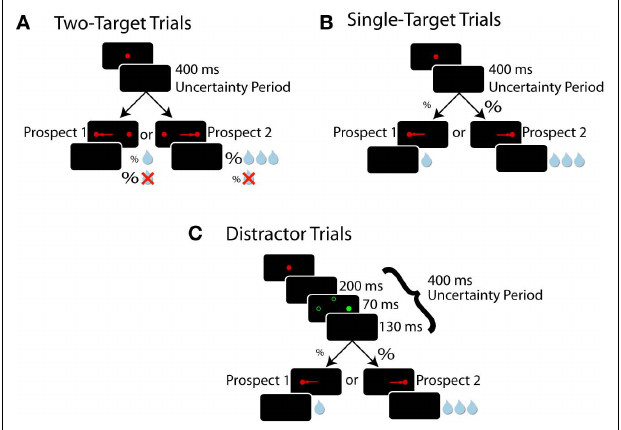
FIGURE 1 | Experimental paradigms. Each window represents what the monkey sees chronologically ordered from top to bottom. Red filled circles represent targets, green filled circles represent distractors, and unfilled green circles represent potential distractor locations. (A) Two-target trials. Both targets are displayed but the reward outcome for choosing a target is probabilistic (%). (B) Single-target trials. Only one of the two potential targets appears, but reward is certain. Note that during a particular prospect block, the probability of target presentation at a particular location in single-target trials equals the probability of receiving a reward for choosing that target during two-target trials. (C) Distractor trials.These trials follow the same pattern as single-target trials, with the addition of an irrelevant green distractor being displayed prior to target appearance. Directing a saccade toward a distractor aborts the trial and reward is